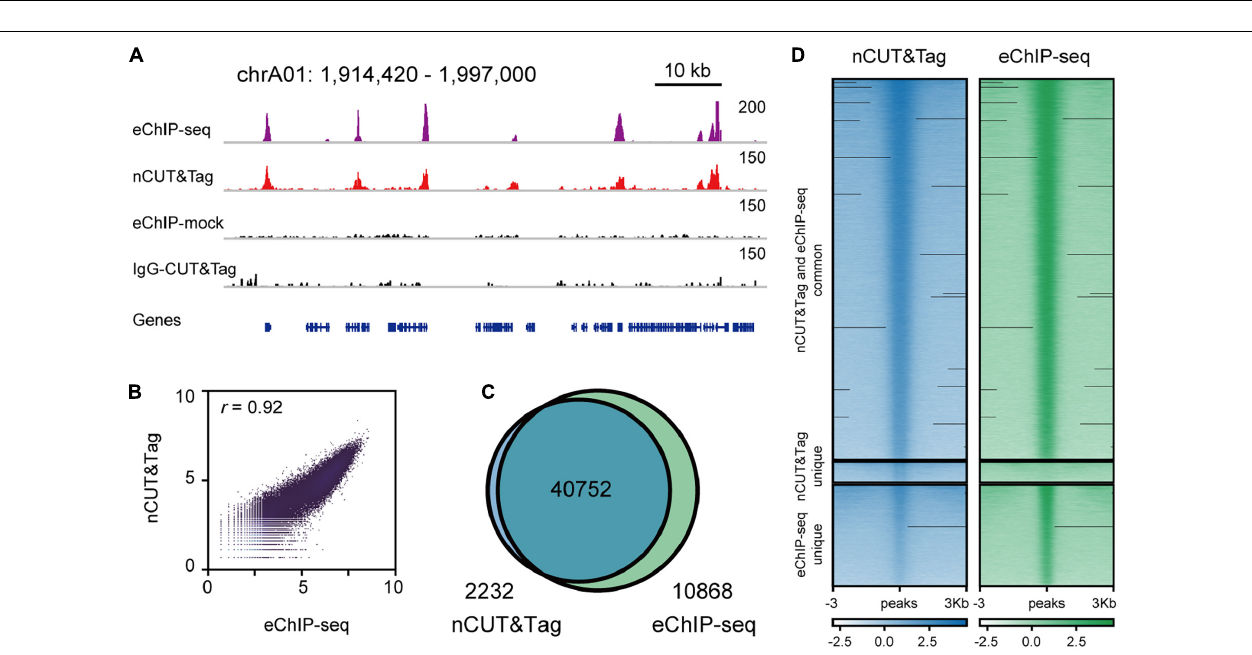
FIGURE 6 | nCUT&Tag for fast chromatin profiling in Brassica napus . (A) Representative H3K4me3 landscapes across chrA01:1,914,420–1,996,975 of the Brassica napus genome generated by nCUT&Tag and eChIP-seq. (B) Scatter plots showing the Spearman’s correlation between the nCUT&Tag and eChIP-seq data. (C) Venn diagram showing the overlap of H3K4me3 peaks detected by nCUT&Tag and eChIP-seq. (D) Comparison of the H3K4me3 nCUT&Tag and eChIP-seq signals.